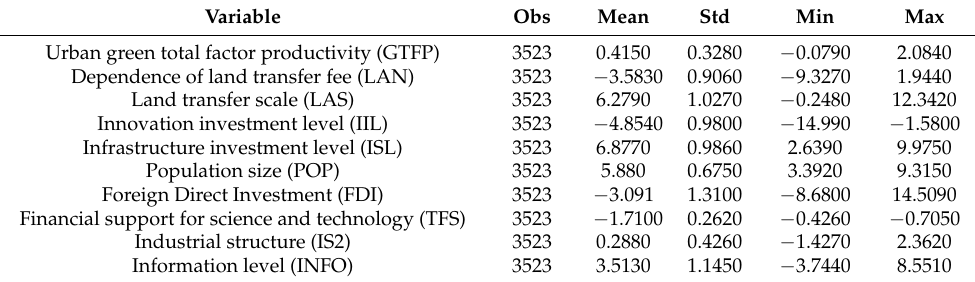
Table 2. Descriptive statistics of main variables (urban level in China).